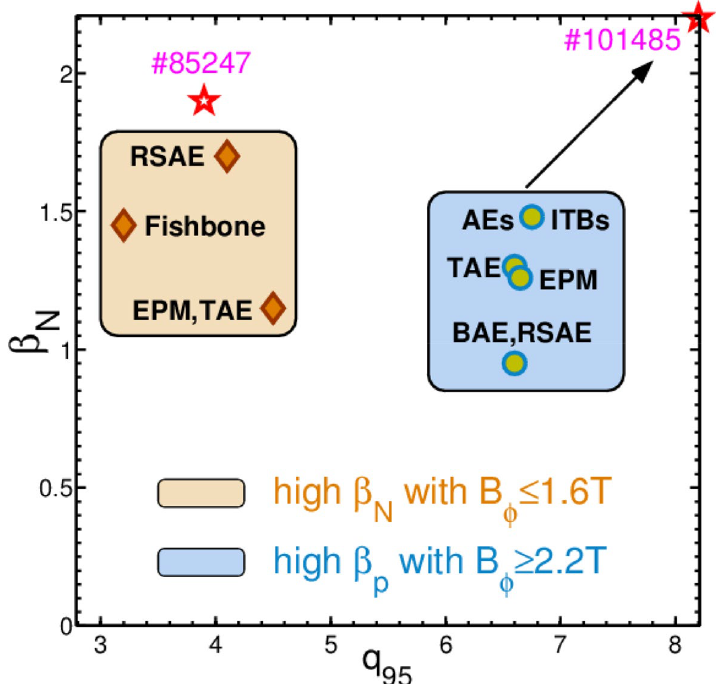
Fig. 11 Parameter range of the fast ion-driven modes existed on